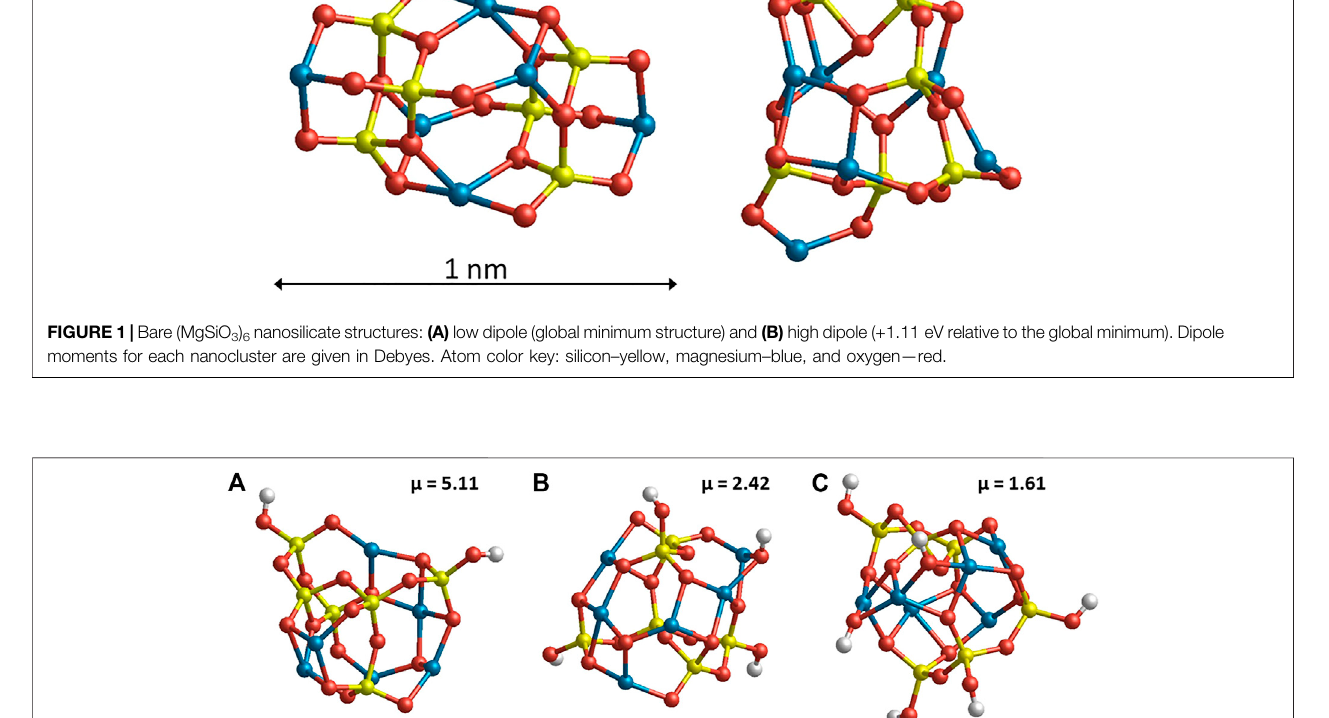
Frontiers in Astronomy and Space Sciences |